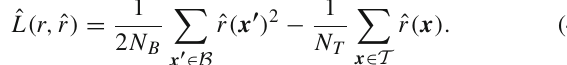
Fig. 6 The effect of N sig (left)and N B (right) on the abilityof the algo- rithm to distinguish B and T . For the left figure, N B = 20 , 000 back- ground events and N T = N B + N sig . (Based on the actual simulated signal and background cross-sections, the true value is N sig = 375.) In